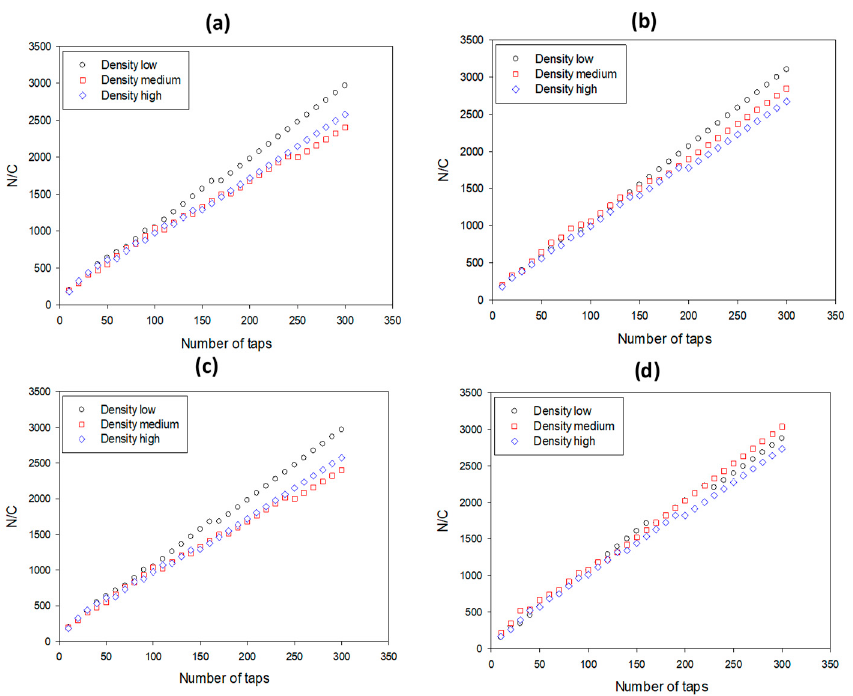
Figure 3. Kawakita plots for: ( a ) small/plain, ( b ) large/plain, ( c ) small/coated, and ( d ) large/coated pellets.